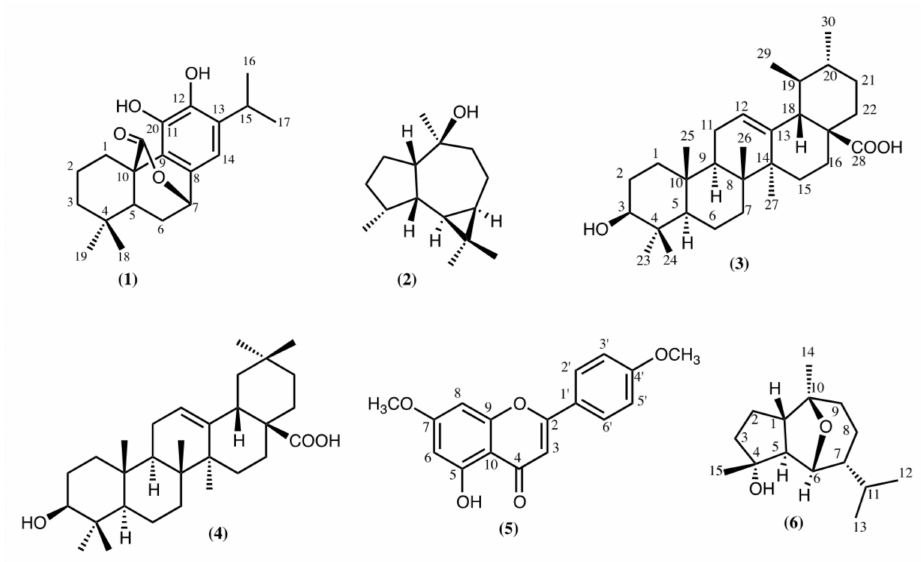
Figure 1. Compounds isolated from the leaves of Lepechinia